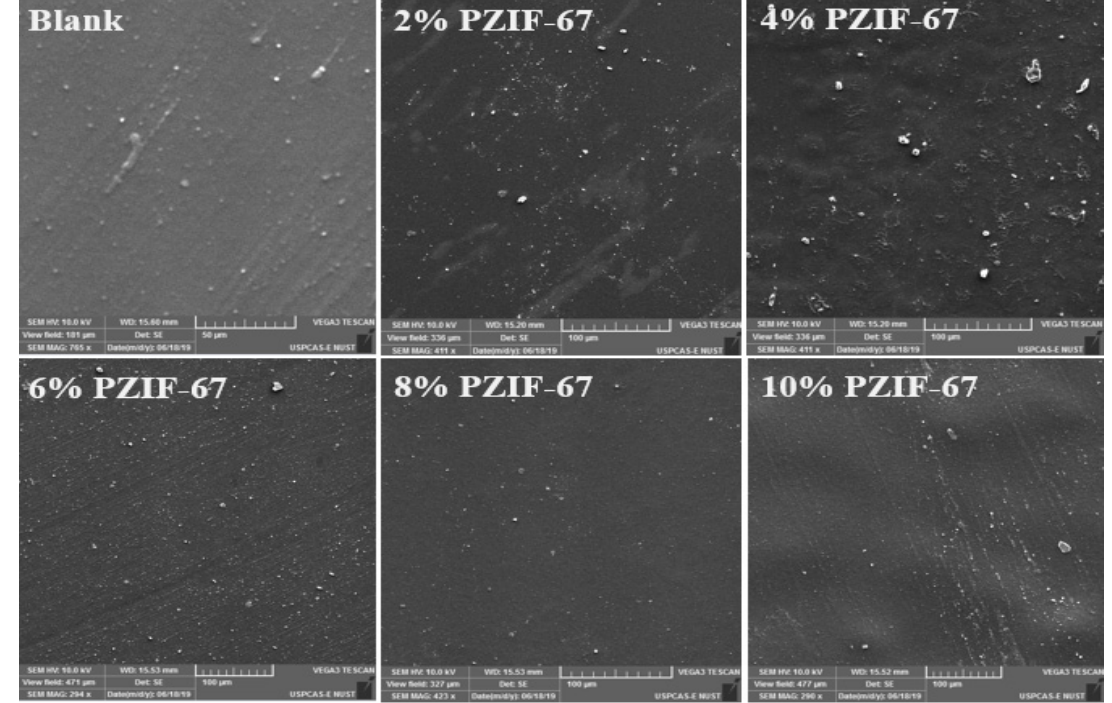
Figure 3. Surface morphology of PVA/starch homogeneous films with various compositions of pyrolyzed ZIF-67 SEM images: Blank, 2 wt.% PZIF-67, 4 wt.% PZIF-67, 6 wt.% PZIF-67, 8 wt.% PZIF-67, and 10 wt.% PZIF-67.